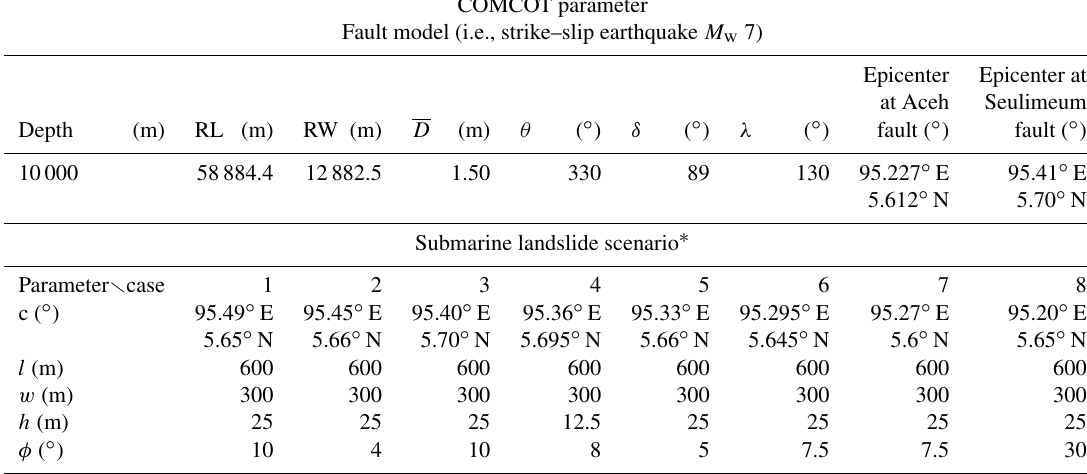
COMCOT parameter